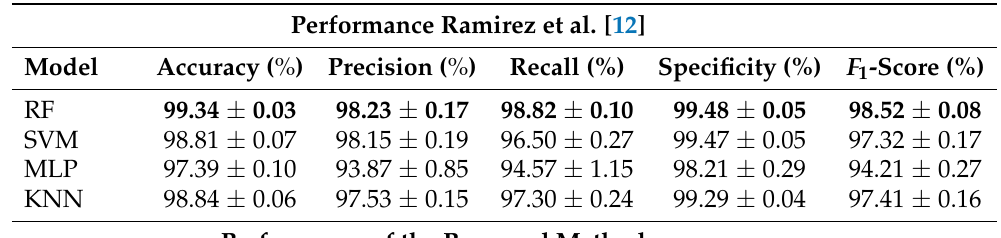
Table 3. Performance (mean ± standard deviation) obtained for each model of the proposed fall detection system using UP-Fall. The best results are shown in bold.